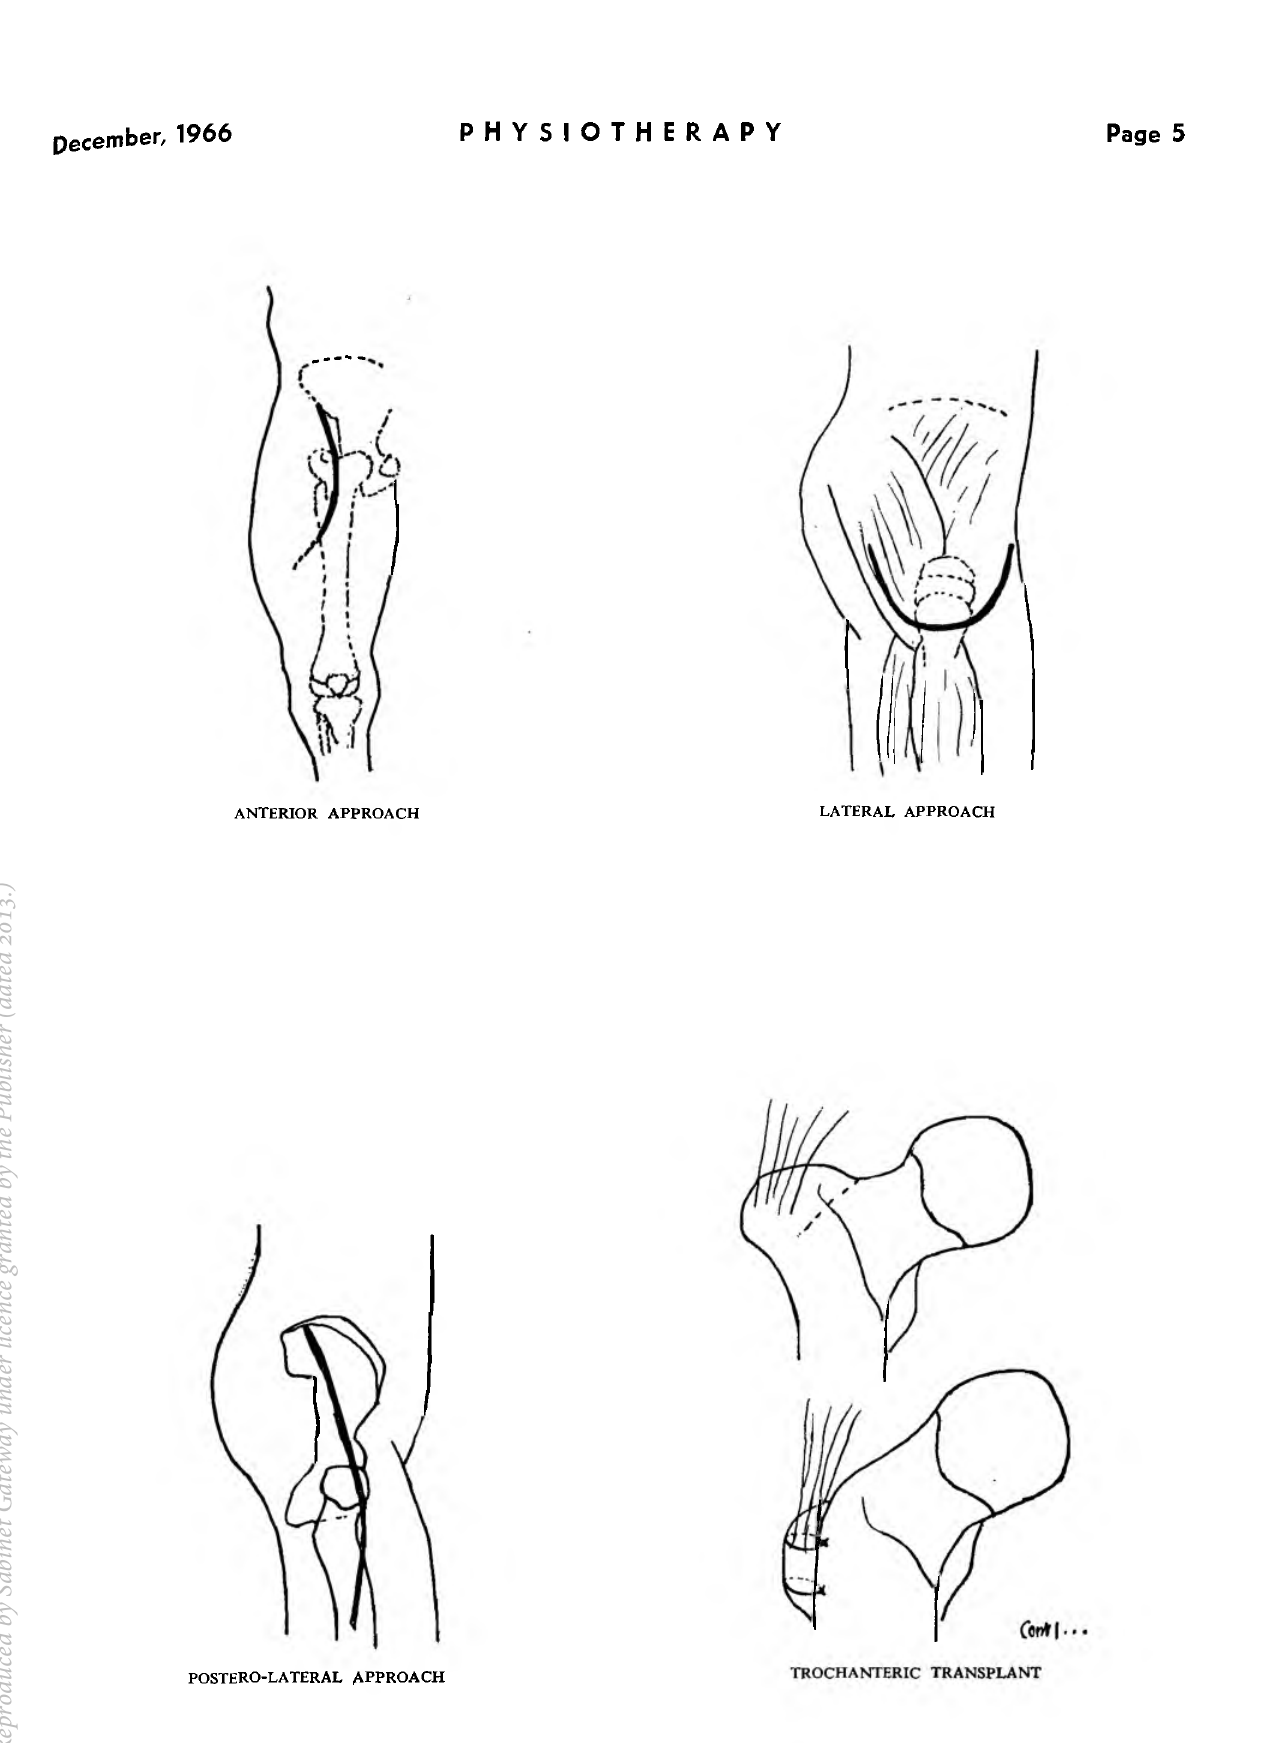
POSTERO-LATERAL